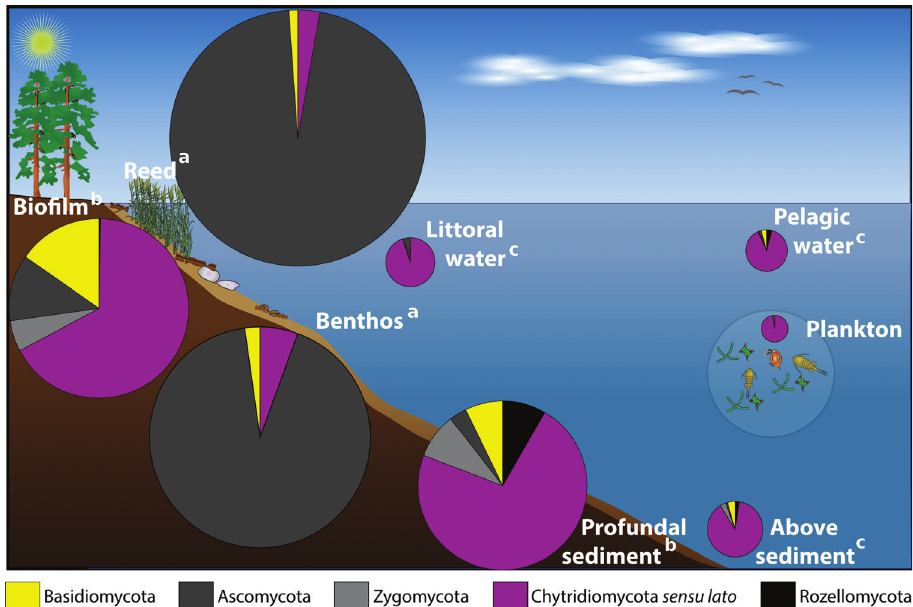
Figure 3. Contribution of fungal phyla within each of the lakes habitat. Pie chart diameters are scaled by the contribution of fungal diversity to the total eukaryotic diversity in each habitat. Lower case letters group significantly different POM types in terms of OTU diversity and fungal reads (Tukey Post-Hoc tests, p < 0.01).